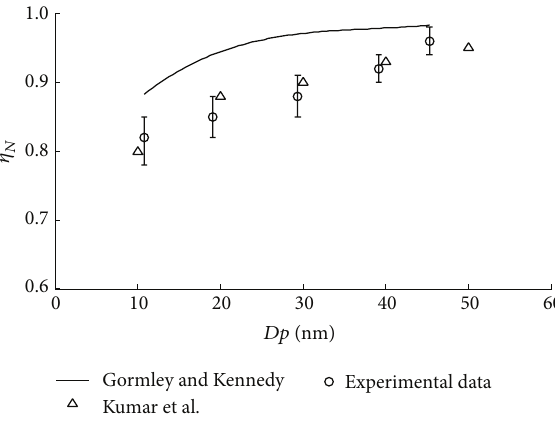
Figure 3: Penetration efficiencies for different particle